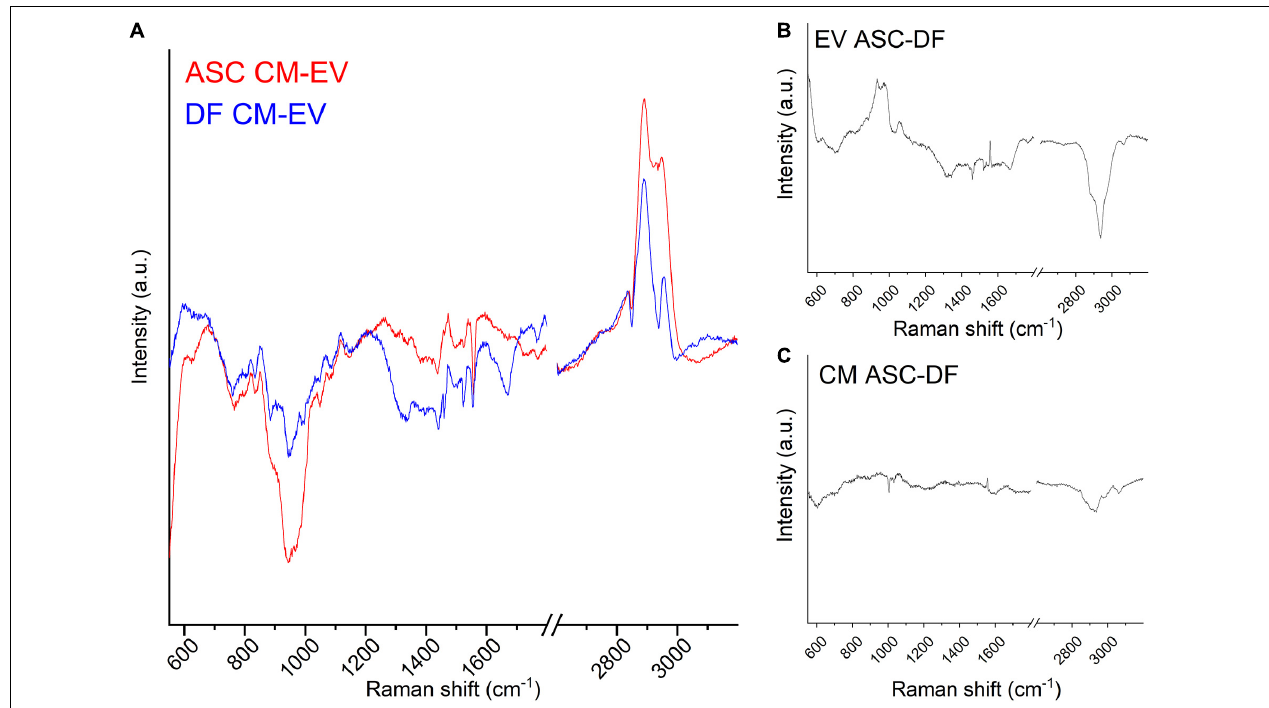
FIGURE 4 | (A) Subtraction spectra obtained for ASC (red line) and DF (blue line) preparations by subtracting the EV average spectrum to the CM average spectrum. (B,C) Subtraction spectra obtained for CM (B) and EV (C) preparations by subtracting the ASC average spectrum to the DF average spectrum. All graphs display the same scale for the y -axis (Intensity of the Raman